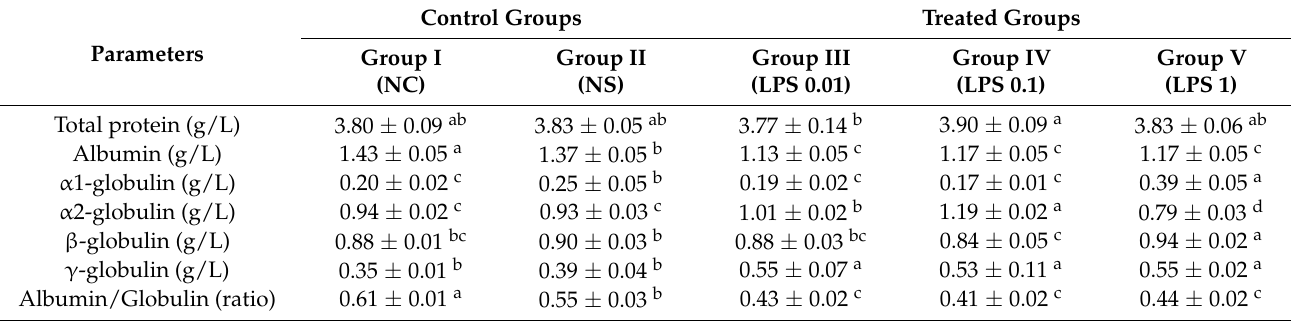
Table 2. Effect of E. coli lipopolysaccharide on the electrophoretic patterns of serum proteins in turkey